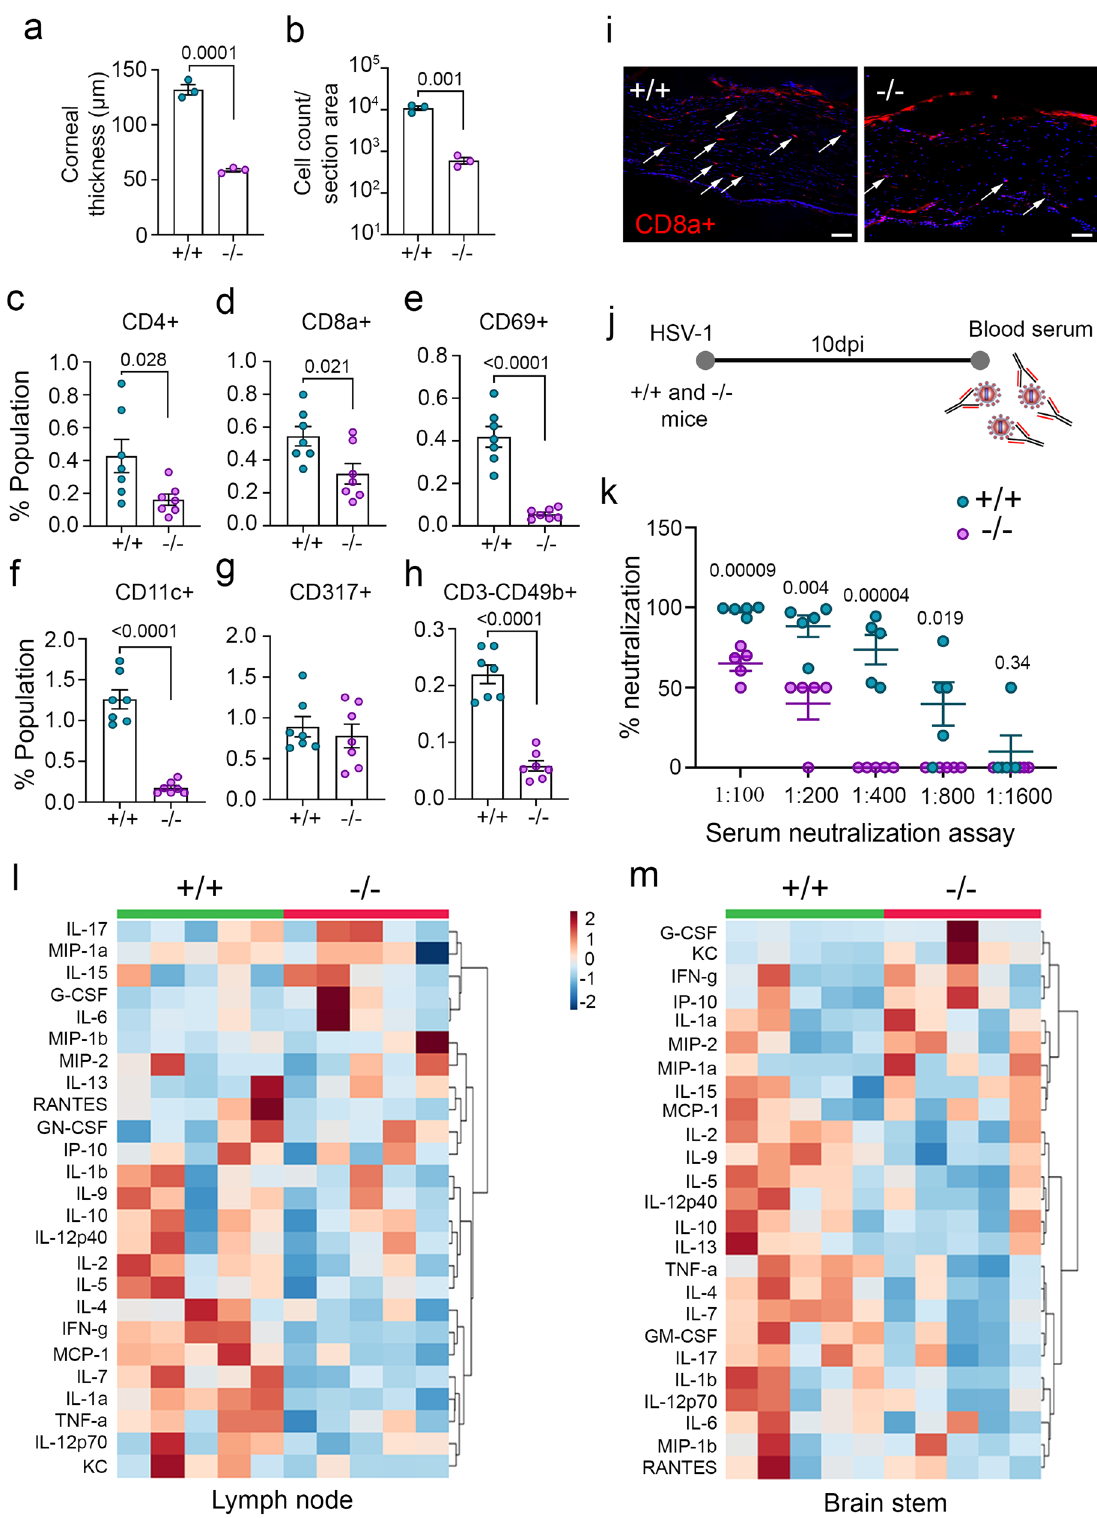
were similar in mock infected animals except for plasmacytoid dendritic cells, which found to be low in iRic − / − animals (Supplementary Fig.